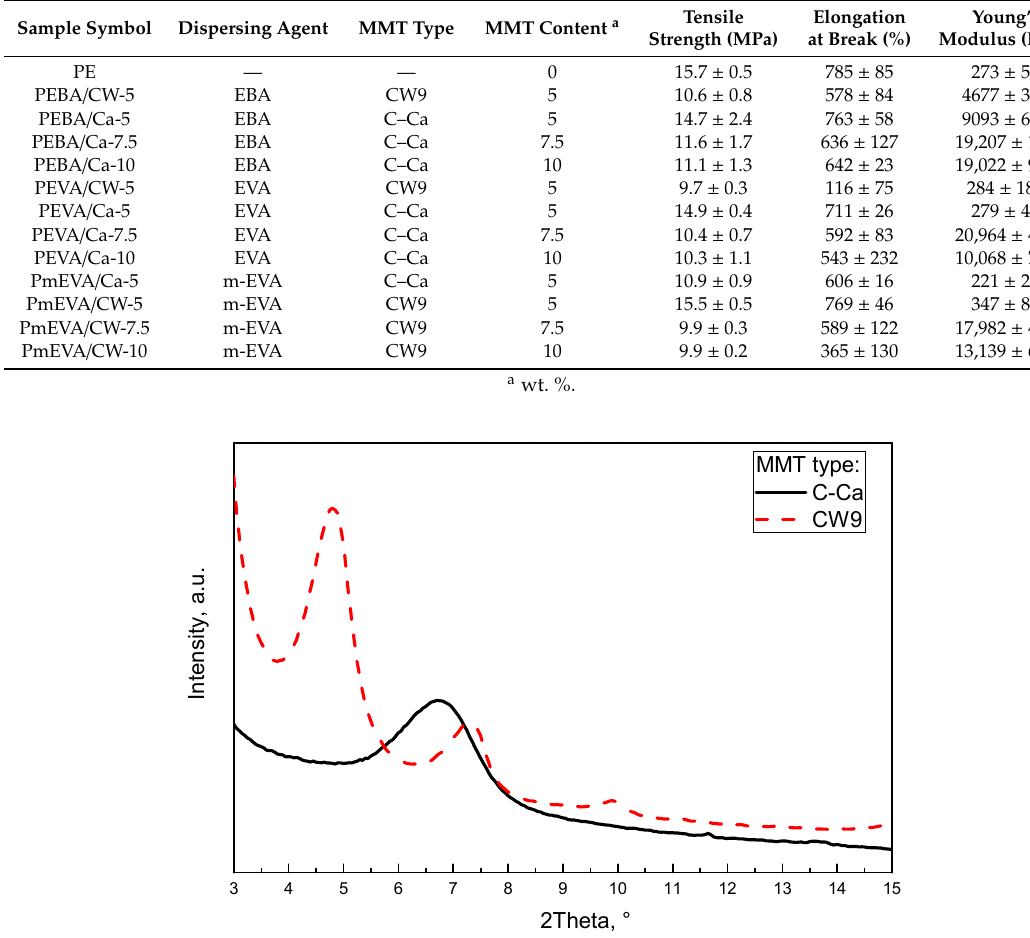
Table 1. Mechanical features of polyethylene (PE)composites with di ff erent montmorillonites (MMTs) and dispersing agents.